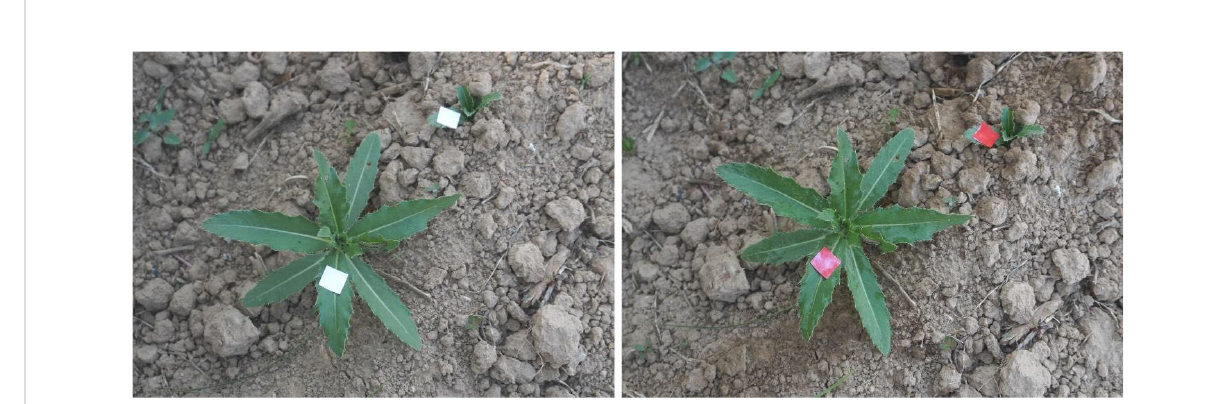
FIGURE 12 Comparison of water-sensitive label changes for target spraying experiments:the left side shows the state of the label before spraying, the right side shows the state after